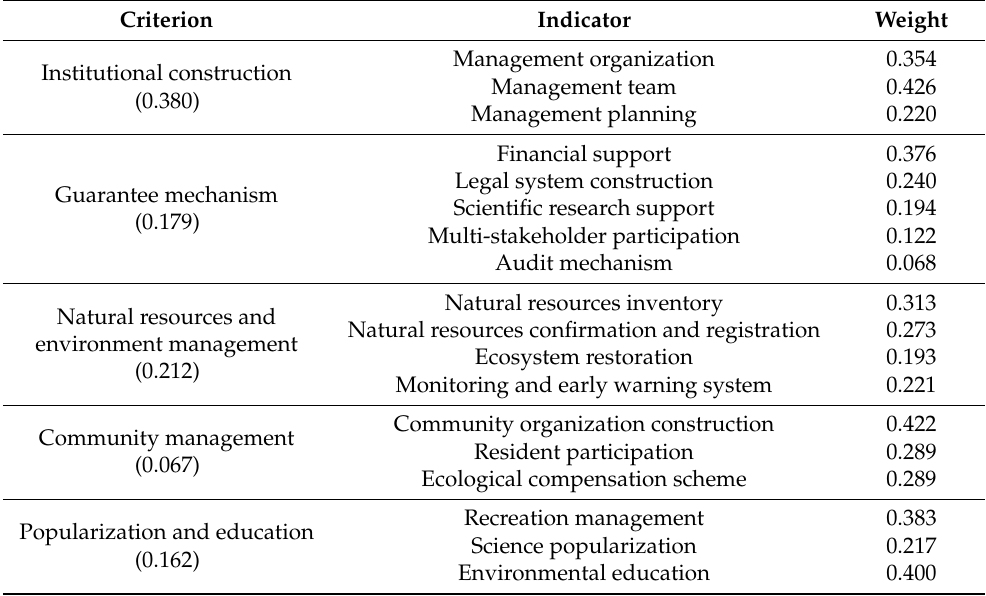
Table 2. Weights of the evaluation indicators of the BPB